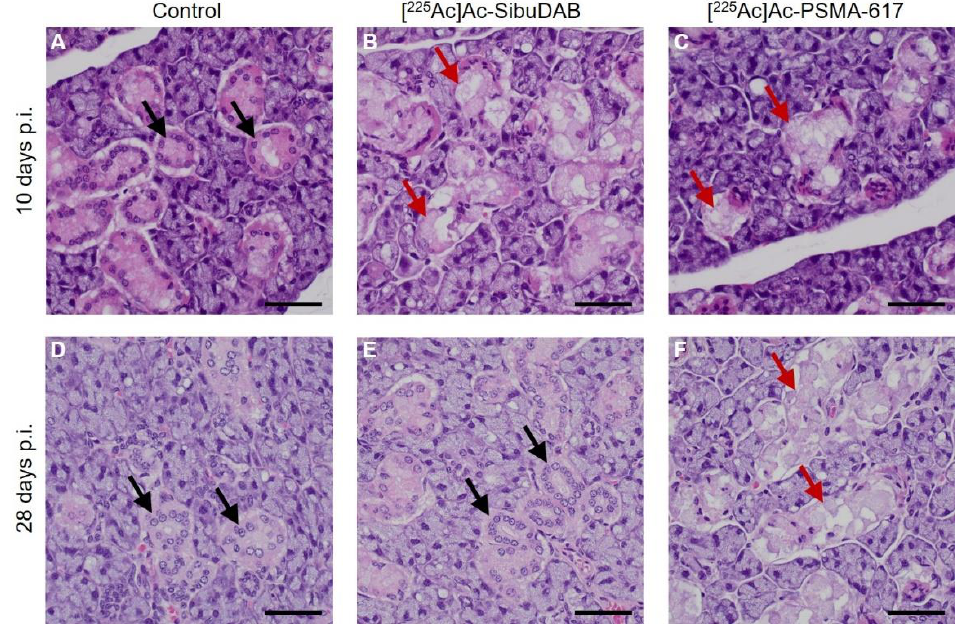
Figure 4. Representative images of H&E stained FFPE histological sections of the salivary glands on Day 10 and Day 28 of ( A , D ) control mice, ( B , E ) mice injected with [ 225 Ac]Ac-SibuDAB and ( C , F ) mice injected with [ 225 Ac]Ac-PSMA-617. The red arrows highlight moderate necrosis of the serous acinar cells; black arrows show intact serous acinar cells. The scale bar corresponds to a length of 100 µm.